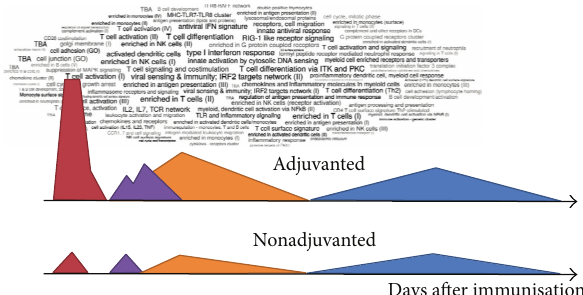
Figure 5: Cartoon illustrating relative expression of related genes over time for an adjuvanted and unadjuvanted vaccine, with the names of the associated overrepresented gene clusters in the first peak (red) for the adjuvanted vaccine identified in the